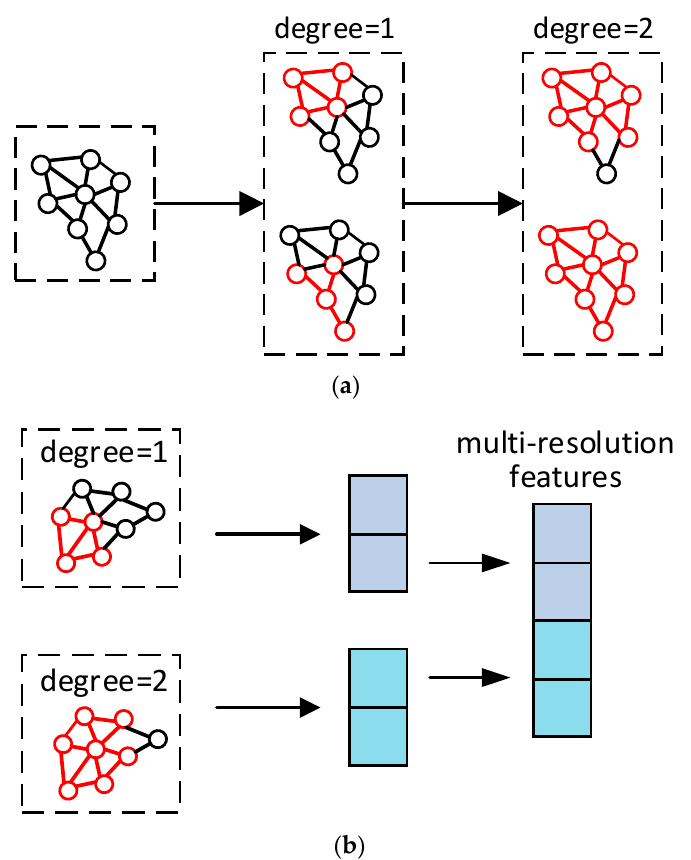
Figure 5. ( a ) Schematic diagram of two-layer graph convolution calculation. ( b ) Feature splicing schematic. Purple represents the information features of the aggregated first-degree neighboring vertices and blue represents the information features of the aggregated second-degree neighboring vertices.